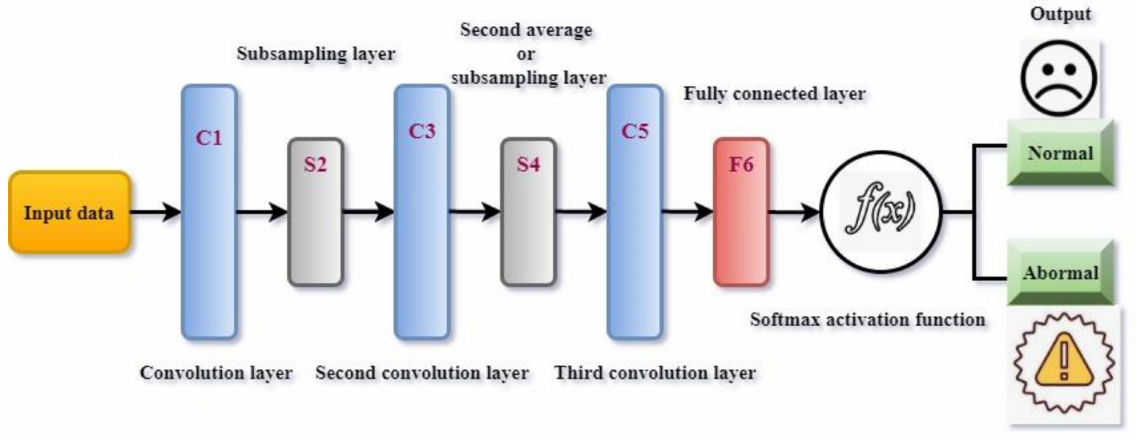
Figure 3. Process of convolute neural